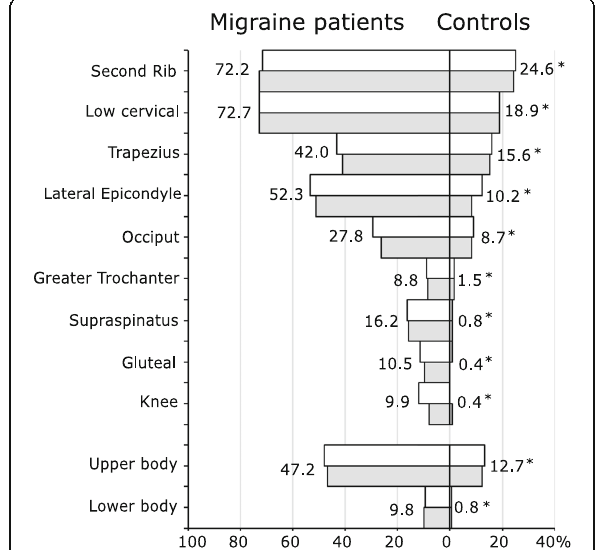
Fig. 2 The percentage of migraine patients (left bars) and controls (right bars) with positive tender point sites examined, arranged in sequence from highest to lowest for controls. White bars and gray and bars indicate right and left, respectively. * p < 0.001, χ 2